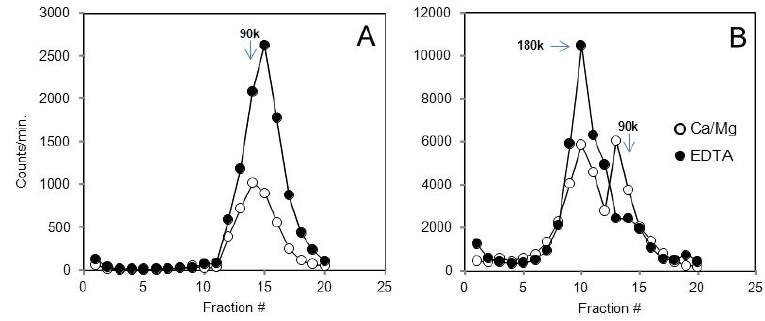
Figure 2. Rundown of the Y2 agonist is much faster in tissues with large G i/o content. The labeling at 50 pM [ 125 I ]PYY(3-36) was for 60 min at 25 °C, to allow a slow conversion of dimers to activated G α - associated monomers and discharge of agonist peptide. The rabbit kidney cortex has a much lower expression of G i/o subunits than the anterior hypothalamus (The B for [ 35 S ]G γ S binding is more than 20-fold higher in hypothalamic tissue max (ref. [24], Table 2). However, the kidney Y2 receptor is expressed at about four times the level of the hypothalamic. The above parameters in the Ca 2+ /Mg 2+ buffer lead to a much faster transduction with hypothalamic particulates (graph A ); and a considerable (58%) rundown of the tracer peptide relative to 1 mM EDTA buffer. In the same assay, the relative rundown is only 12% with kidney particulates (graph B ).